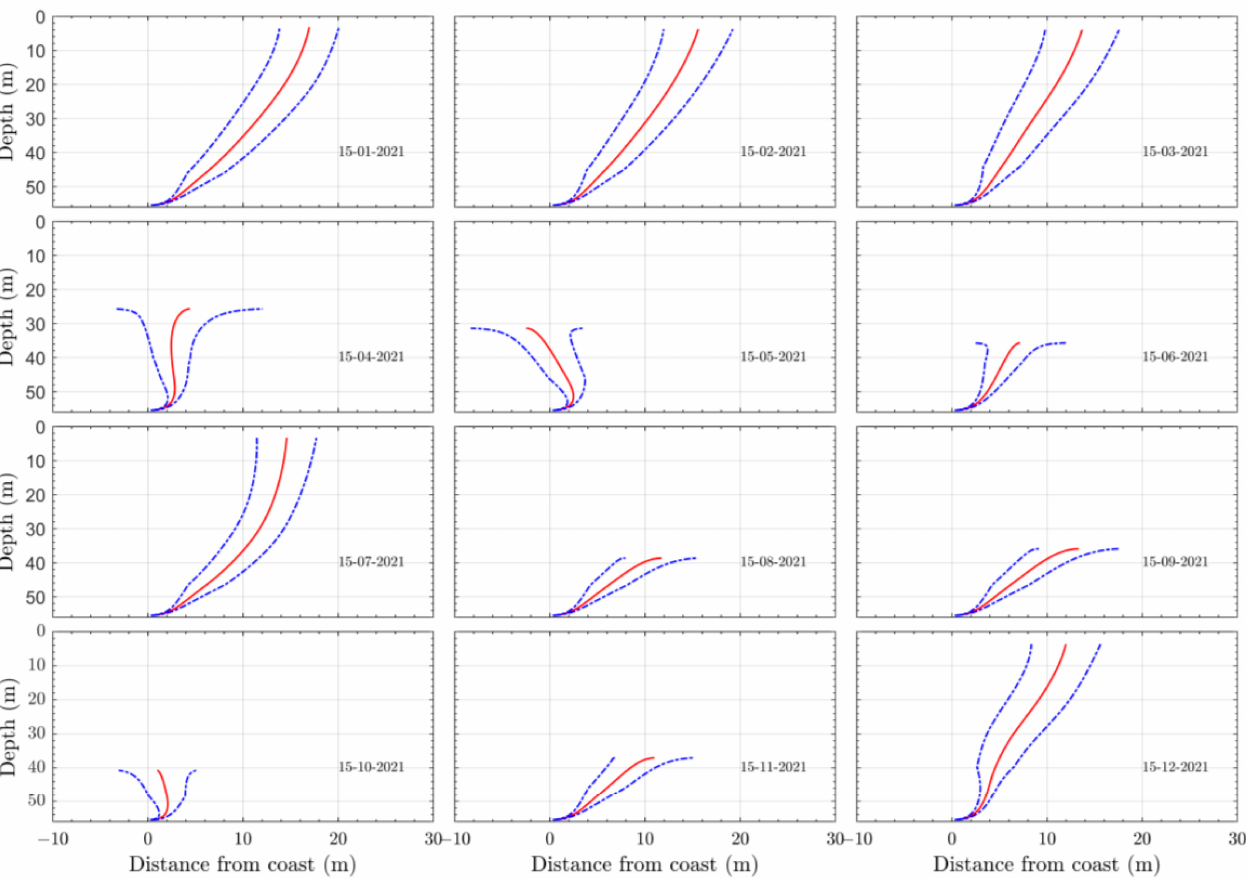
Figure 10. Trajectory of the plume formed by the discharge of the last diffuser of the Santa Marta submarine outfall with wave effects, center plume (red line), plume extension (dashed blue line).